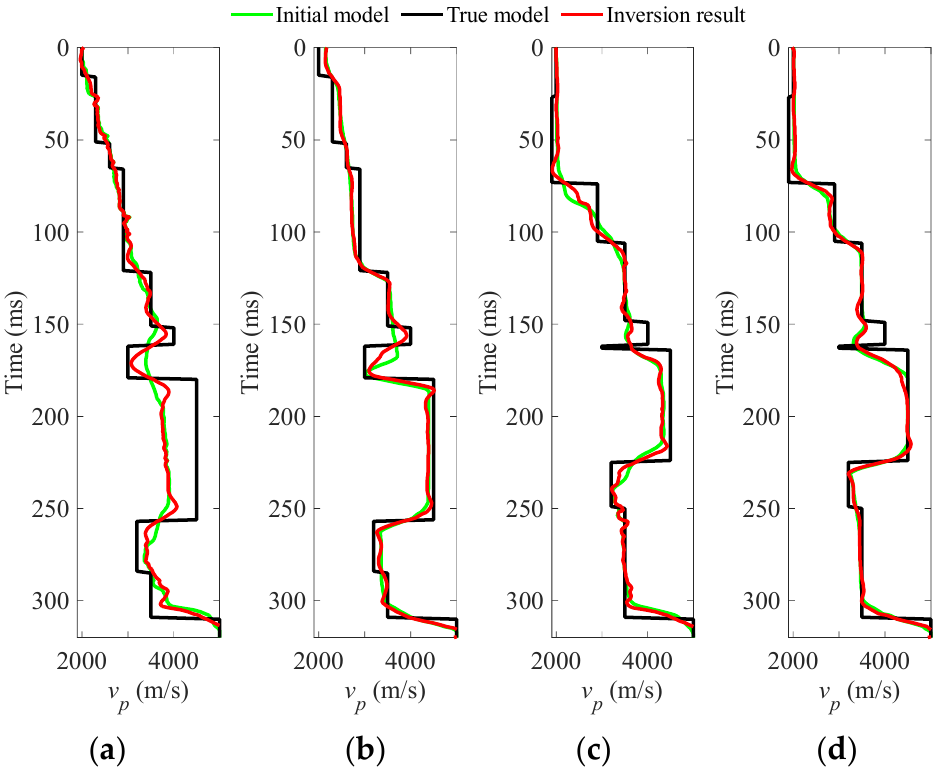
Figure 11. Prestack seismic inversion results of P-wave velocity at CDP 10 by ( a ) KI model and ( b ) FM-NLM, and inversion results at CDP 295 by ( c ) KI model and ( d ) FM-NLM.